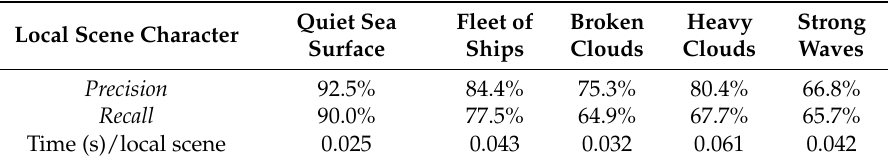
Table 3. RSM ship candidate extraction